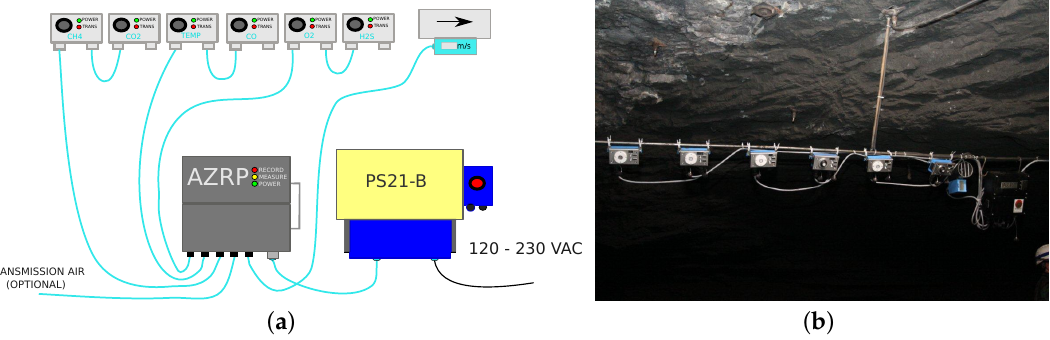
Figure 2. Measurement system used in the experiment. ( a ) Measurement system—scheme [25], ( b ) photo of sensors installed in the